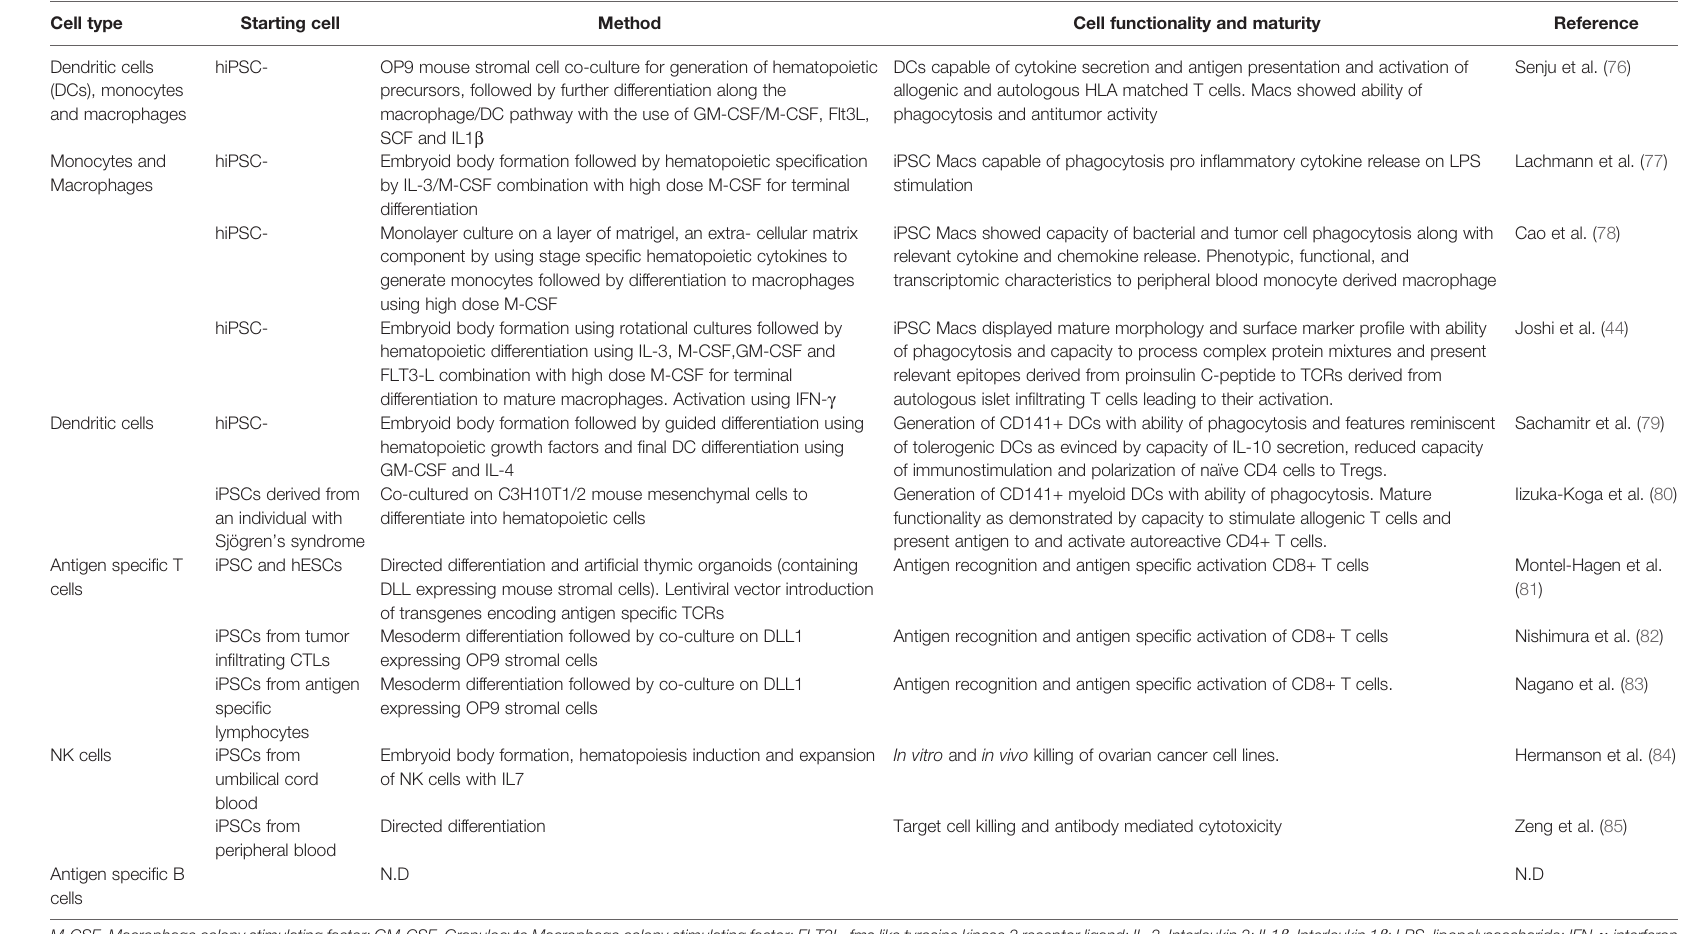
TABLE 2 | Generation of T1D relevant immune cells from